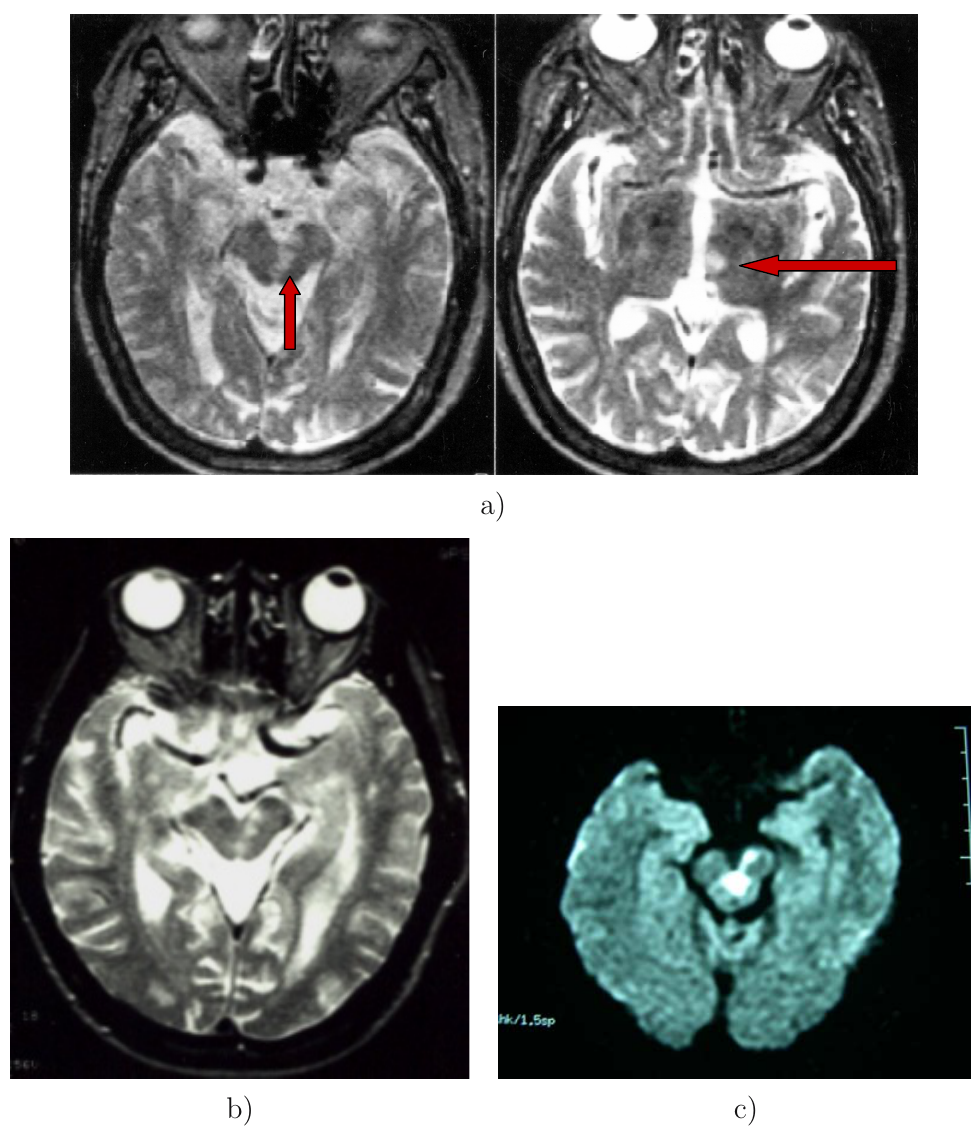
Fig. 1 Magnetic resonance images show unilateral acute infarctions of the paramedian midbrain and medial thalamus in a patient with paramedian mesencephalic artery syn- drome (T2-weighted image) (A). T2WI (B) and Diffusion weighted image (DWI) (C) of another case shows an infarction involving the paramedian midbrain and left cerebral